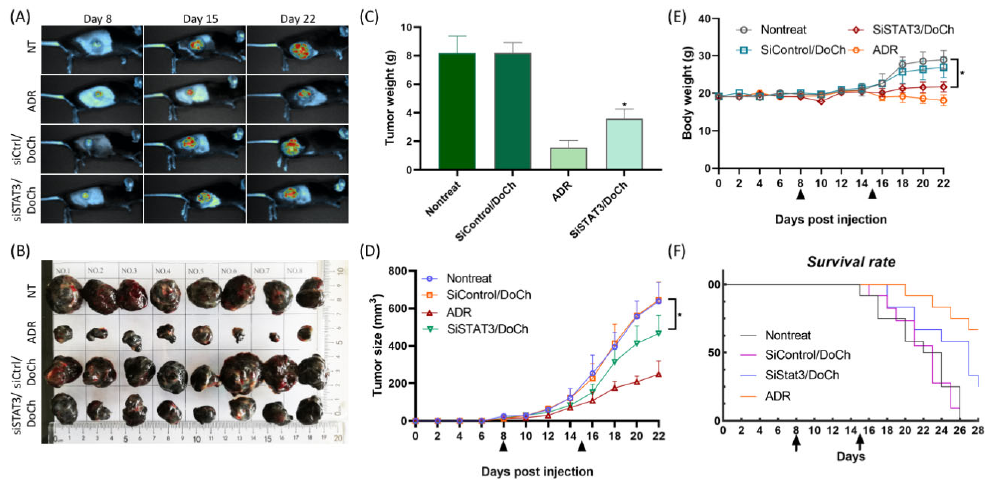
Figure 6. Antitumor e ffi ciency of DoCh LNP mediated tumor-targeted siRNA delivery. ( A ) Live animal imaging and ( B ) images of dissected tumor of nontreated (NT), ADR treated, siSTAT3 / DoCh and siCtrl / DoCh treated B16F10 mouse melanoma model. Live animal images were taken at day 8, day 15 and day 22, and tumor images were taken from dissected tumors at the end of experiment (day 22). Body weight ( C ), tumor volume ( D ) and tumor weight ( E ) of mice treated with siSTAT3 / DoCh LNP decreased, while survival rate significantly extended ( F ). ADR, Adriamycin. * p value is < 0.05.